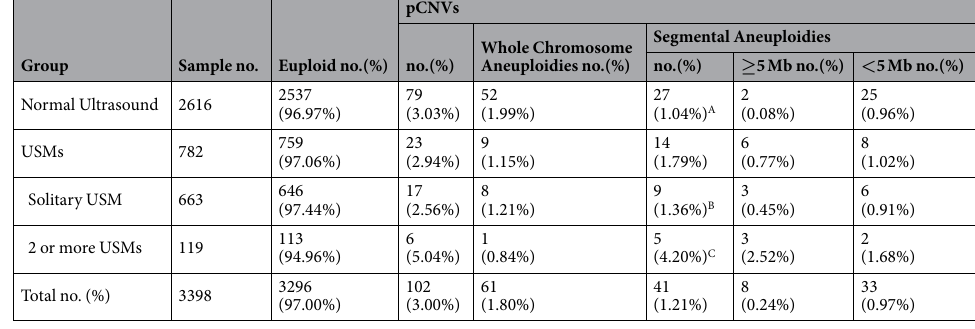
Table 1. Pathogenic copy number variations (pCNVs) in different fetal risk groups. Chi-squared (X2) test was applied to compare pCNVs detection rate in different groups, A vs C: p = 0.002, B vs C: p =